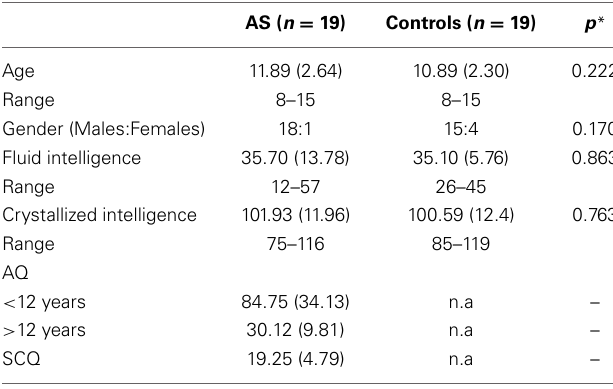
Table 1 | Mean (SD) and range values for baseline characteristics of the